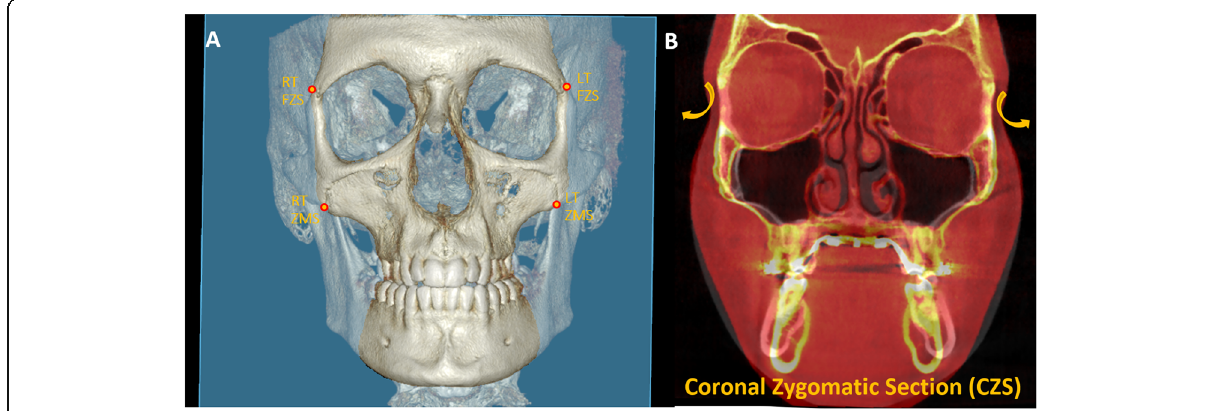
Fig. 5 a 3D reconstruction with the coronal zygomatic section in blue passing through the right and left frontozygomatic sutures (FZS) and zygomaticomaxillary sutures (ZMS). b Pre-treatment and post-treatment superimposed image of an MSE patient in the coronal zygomatic section. The rotational arrows on yellow show the archial movement of the zygomaticomaxillary complex in the coronal